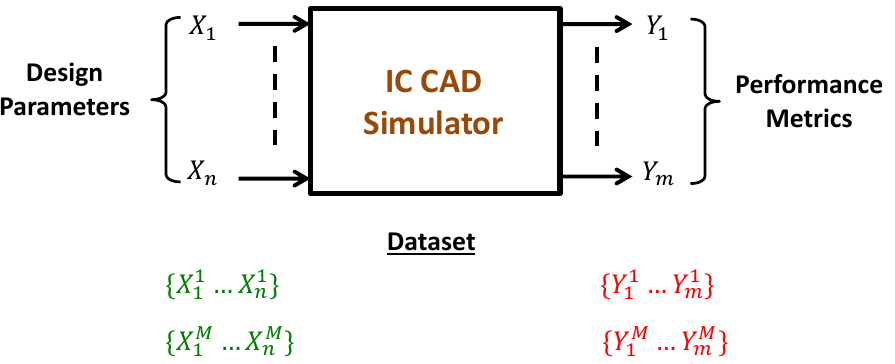
Figure 1. Generation of the training dataset using integrated circuit CAD